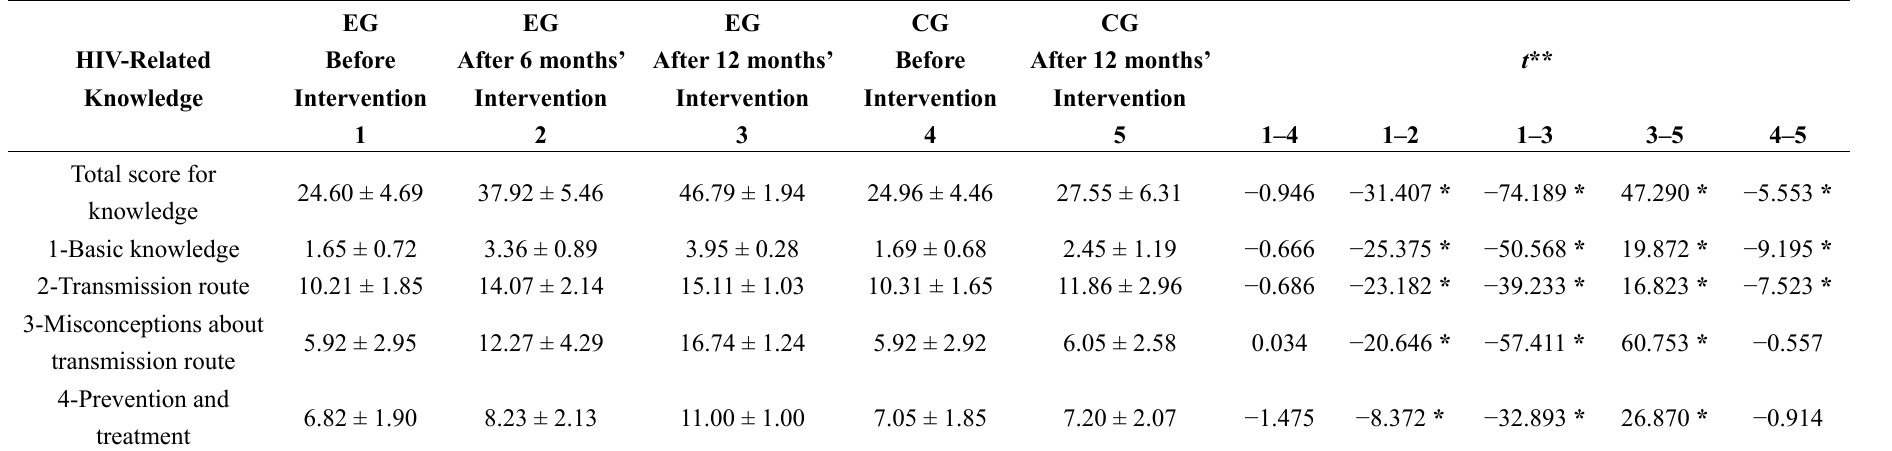
Table 2. Differences in HIV/AIDS knowledge scores.